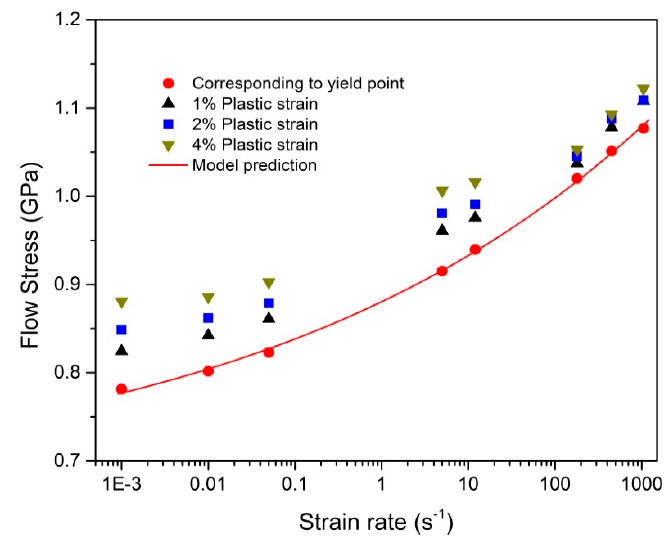
Figure 3. Flow stress versus logarithm strain rate. Table 2. Strain rate sensitivity (SRS) within various strain-rate ranges.